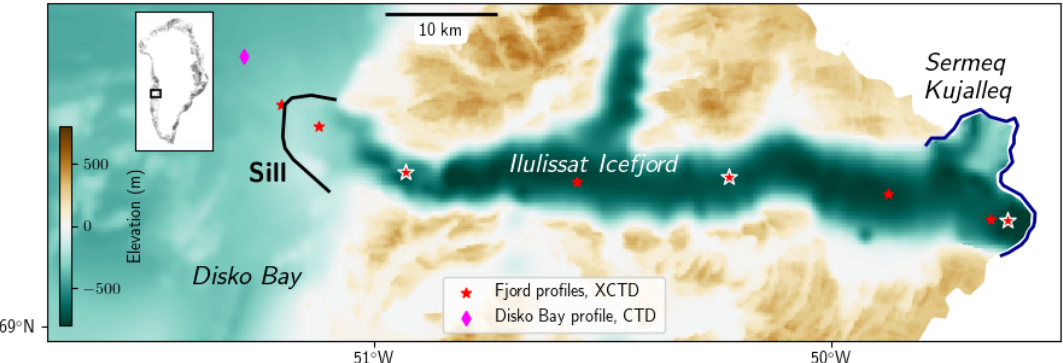
Figure 1. Map of Ilulissat Icefjord, indicating the sill (black line) and Sermeq Kujalleq front location (blue line) in 2014. XCTD profile locations are marked with red stars, and the CTD profile location used for the boundary condition is marked with a pink diamond, all obtained in August 2014 (Beaird et al., 2017). Next-to-glacier, mid-fjord and close-to-sill profiles used in result plots are marked with a white outline. Bathymetry and topography are from BedMachine v3 (Morlighem et al., 2017).